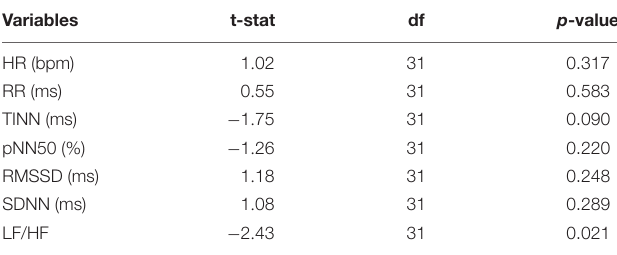
TABLE 4 | Results of the t -test were computed to compare the HRV metrics evaluated from the PPG signal and the correspondent metrics estimated by the cross-validated